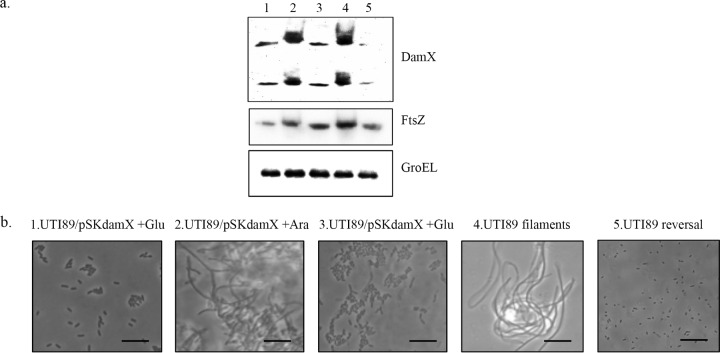
The UTI89 morphological state is reflected in DamX protein levels. (a) Western blot analysis of DamX was performed. Lanes: 1, strain UTI89/pSKdamX under 0.4% glucose repression prior to seeding on glass slides; 2, strain UTI89/pSKdamX filaments induced by 0.2% arabinose; 3, strain UTI89/pSKdamX filament reversal under 0.4% glucose; 4, native UTI89 filaments; 5, reversed native filaments. Both of the upper bands correspond to DamX (34), the middle panel corresponds to FtsZ levels, and the bottom panel shows GroEL expression, which was used as the internal loading control. (b) Microscopic examination of UTI89 strains from each of the respective samples from lanes 1 to 5 was performed to confirm morphological status. Scale bars, 20 µm.